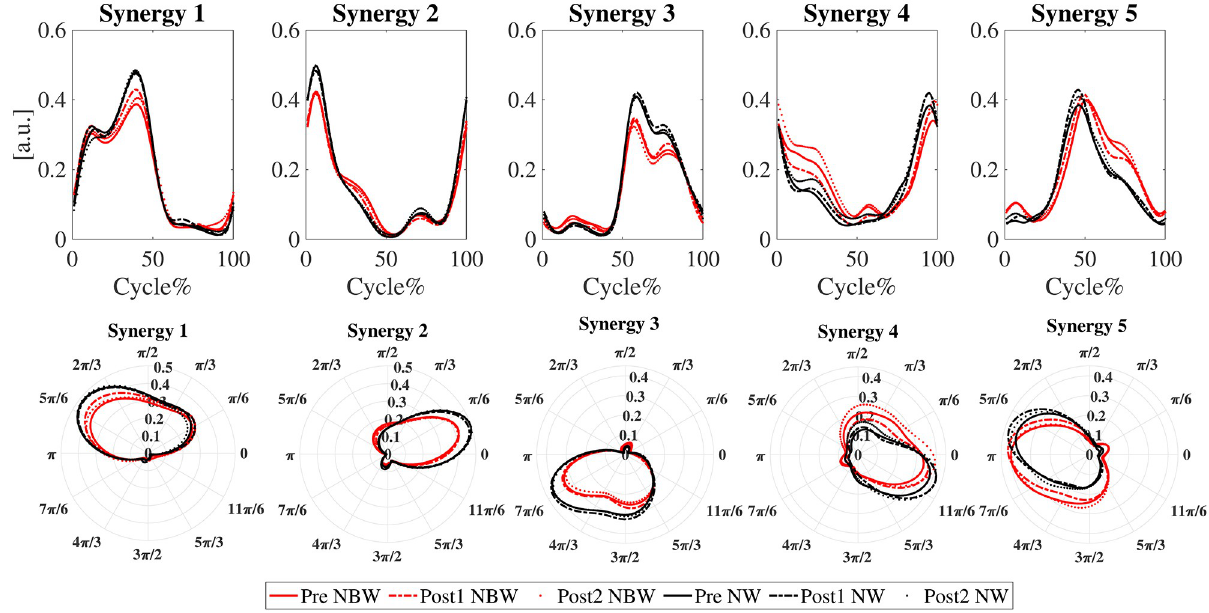
Fig 8. Activation profiles of the extracted synergies as time series and in polar coordinates in narrow-base and normal walking at time-points Pre (solid), Post1 (dash-dot), and Post2 (dotted). The x-axis in the Cartesian coordinates represents one gait cycle. One gait cycle in polar coordinate is [0, 2 π ]. Black, normal walking; red, narrow-base walking.